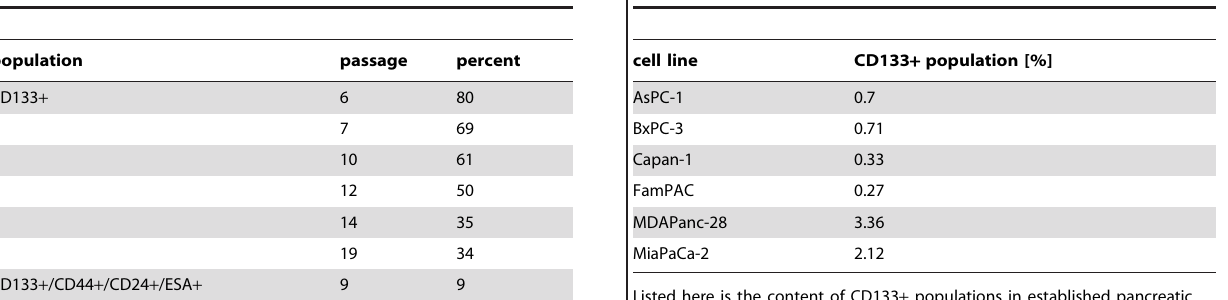
Table 2. Expression of CD133 in established pancreatic cancer cell lines.